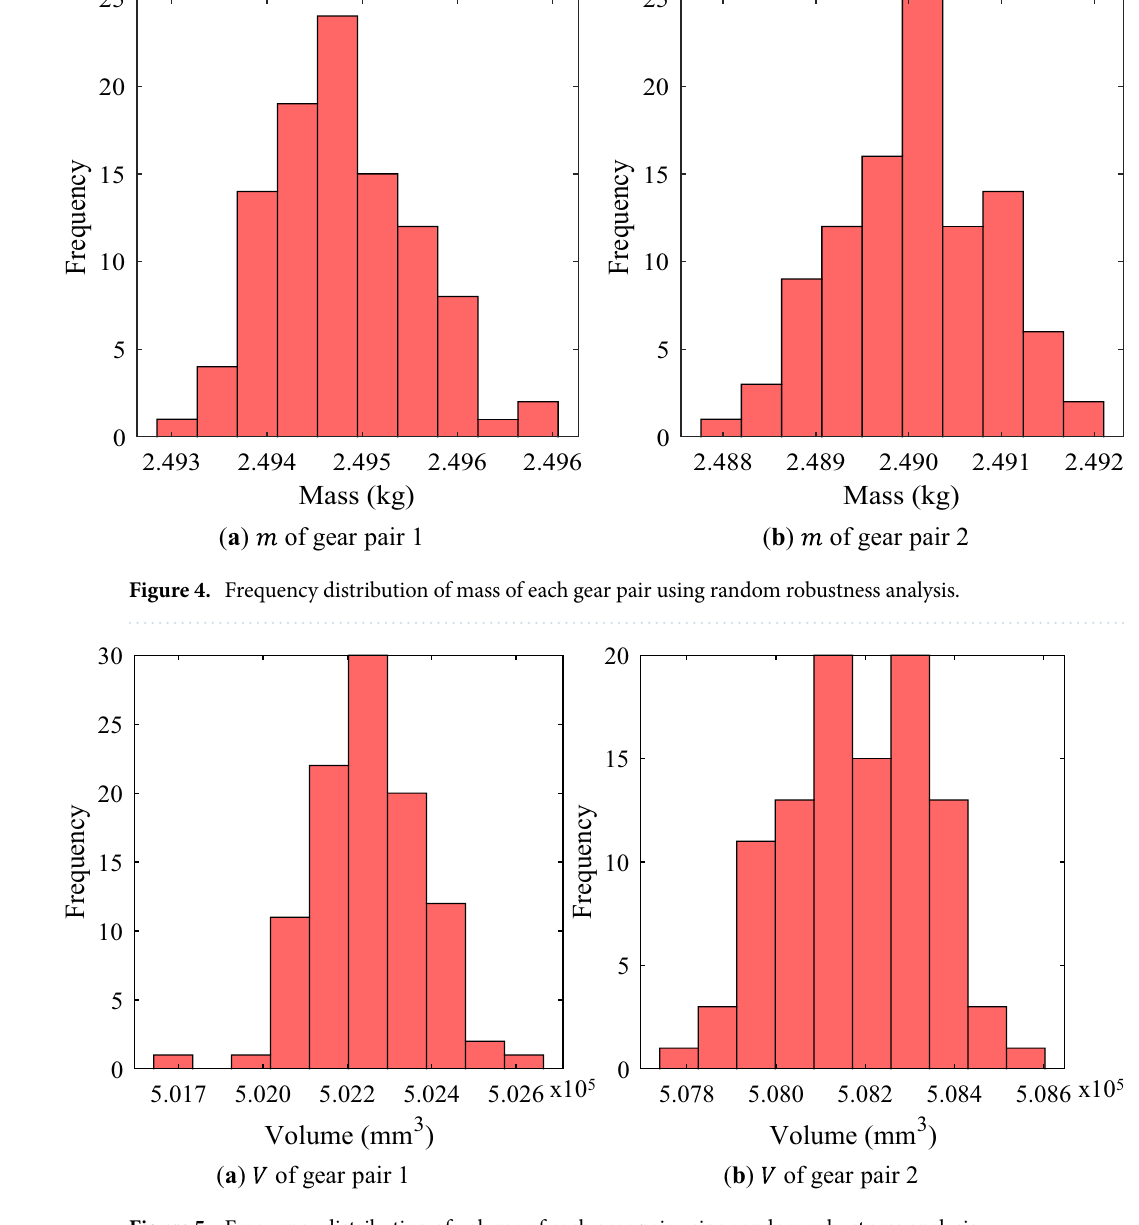
Figure 5. Frequency distribution of volume of each gear pair using random robustness